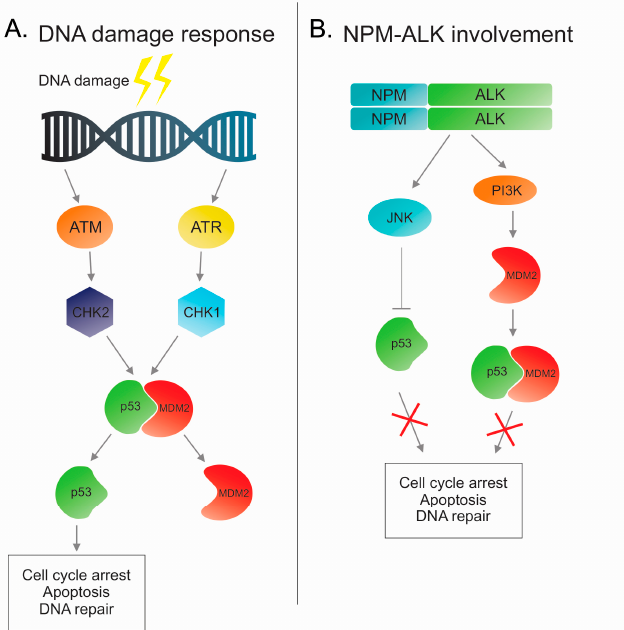
Figure 1. Involvement of nucleophosmin (NPM)-anaplastic lymphoma kinase (ALK) in DNA damage response pathway. ( A ) A schematic overview of the DDR pathway with the stimulation of ataxia telangiectasia mutated (ATM) or ATM-Rad3-related (ATR) after DNA damage and the following cascade including p53 activation. ( B ) NPM-ALK activates (Jun-N-terminal kinase) JNK or phosphatidylinositol-3-kinase (PI3K) pathways and the subsequently inhibits the p53 pathway. 3. NPM-ALK Induces Cellular Senescence in Anaplastic Large Cell Lymphoma